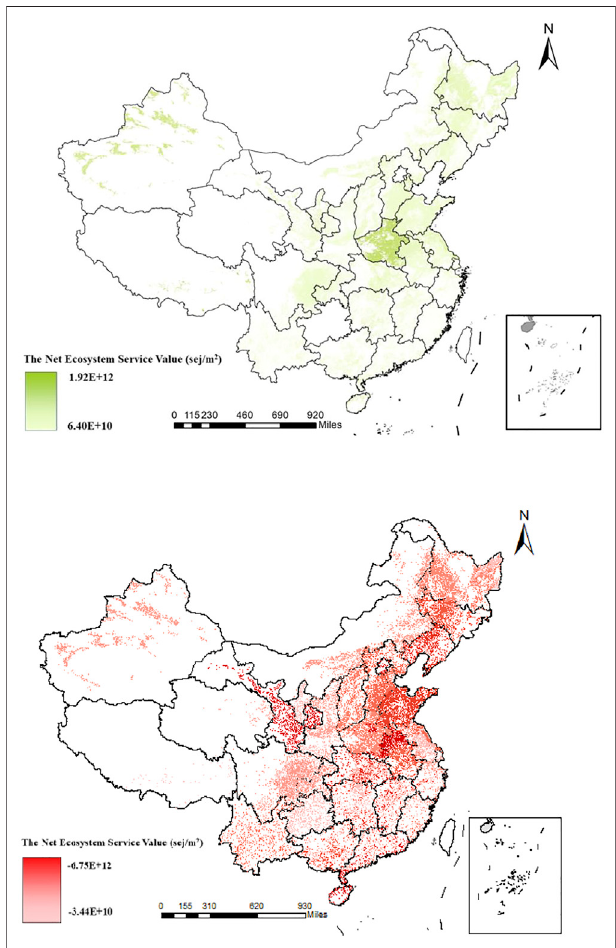
FIGURE 5 | The spatial distribution of the net ecosystem services